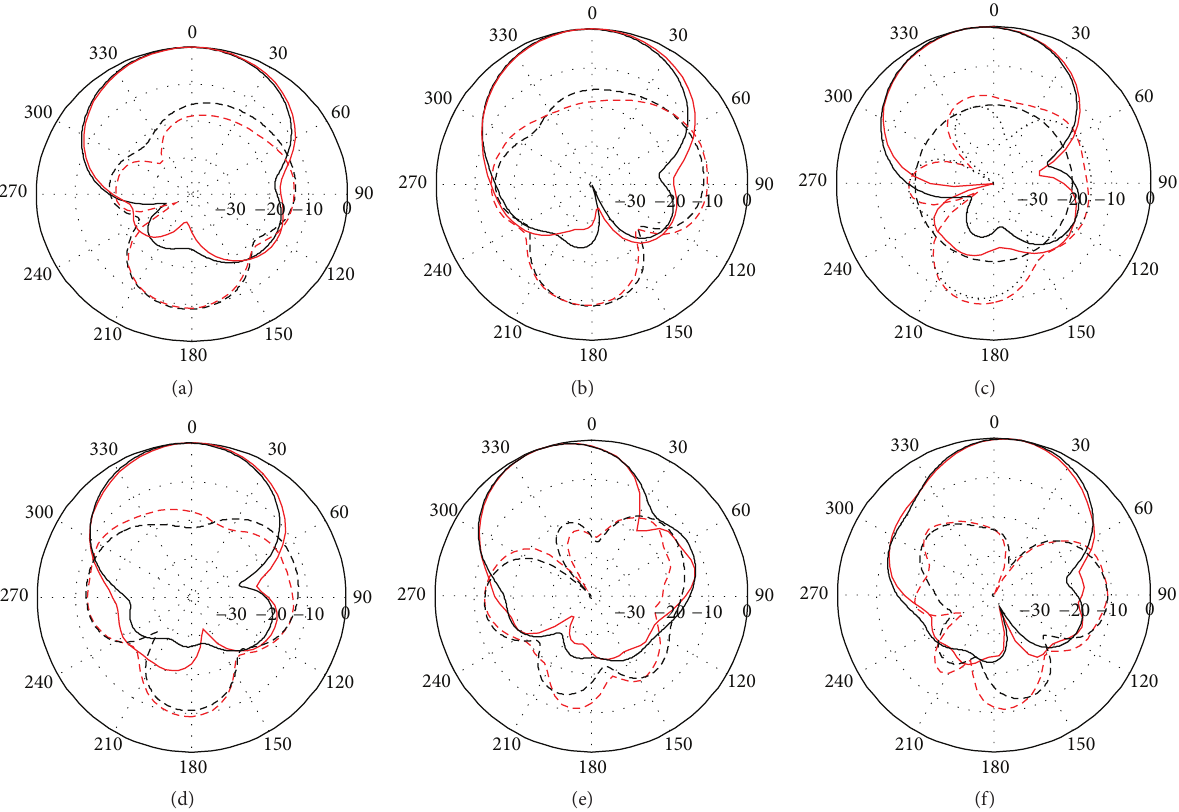
Figure 9: Radiation patterns of the proposed strip-helical antenna at 1.25 GHz, 1.625 GHz, and 2GHz, respectively. Black line: measured data; red line: simulated data. Solid line: RHCP; dashed line: LHCP. (a) 𝑓 = 1.25 GHz, 𝜙 = 0 ∘ plane, (b) 𝑓 = 1.25 GHz, 𝜙 = 90 ∘ plane, (c) 𝑓 = 1.625 GHz, 𝜙 = 0 ∘ plane, (d) 𝑓 = 1.625 GHz, 𝜙 = 90 ∘ plane, (e) 𝑓 = 2 GHz, 𝜙 = 0 ∘ plane, and (f) 𝑓 = 2 GHz, 𝜙 = 90 ∘